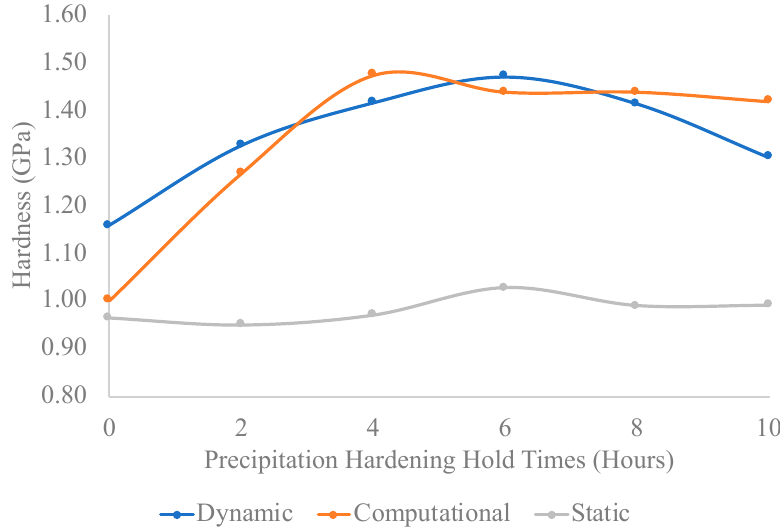
Figure 15. Dynamic, static and computational hardness’s obtained with the iMicro Pro. The slight dissimilarity between the dynamic and computational hardness’s may very well follow from the cursory dislocation density term in the computational additive yield strength model that will be detailed soon hereafter in the manuscript.